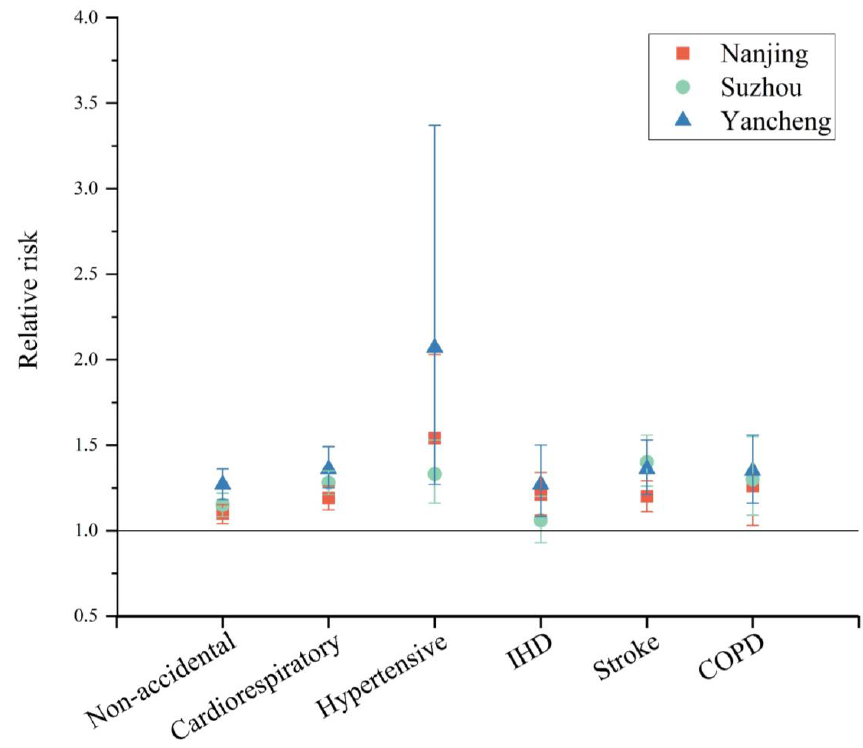
Figure 5. Mortality relative risk stratified by cause of death.